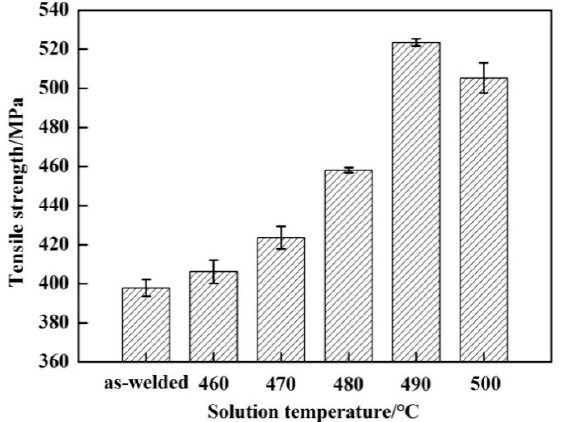
Figure 8. Tensile strengths of welded joints between as-welded and PWHT with solution at different temperatures for 60 min followed by aging at 120 °C for 24 h.